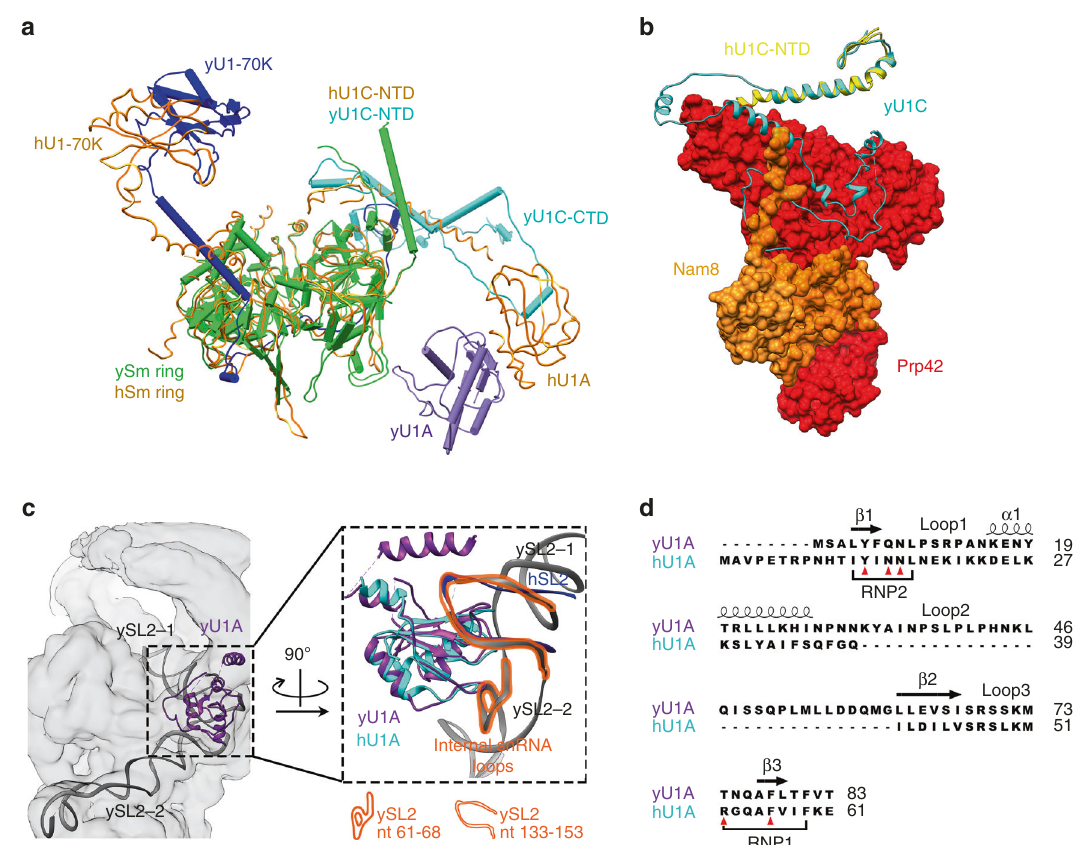
Fig. 3 The similarities and differences between yeast and human U1 snRNP core. a . The core protein components between human and yeast U1 snRNP are organized similarly. All human U1 components are colored in orange (PDB ID 3PGW and 3CW1), while yeast Sm ring, U1-70K, U1C, and U1A are colored in cyan, blue, green, and purple, respectively. The two U1 snRNPs are superimposed through their Sm rings. U1A and U1-70K positions are slightly shifted. U1C-NTDs overlap, while the U1C-CTD is not visible in the human U1 snRNP structure. b Yeast U1C-NTD (green) superimposes well with that of human U1C (yellow, PDB ID 3CW1). The C-terminal region of yeast U1C interacts extensively with Prp42 (red) and to a lesser extent with Nam8 (orange). c Yeast U1A (purple) binds to the internal loop region (nt 61 – 68 and nt 133 – 153) between SL2-1 and SL2-2 (black). In the inset panel, the human U1A RRM1 (cyan, PDB ID 1OIA) structure is superimposed on yeast U1A RRM1 (purple). The β -sheet face of yeast U1A RRM1 binds to the internal loop (nt 133 – 153, highlighted in orange) located in a similar position as the RNA (dark blue) that human U1A binds. The yeast U1A also binds to the second internal loop (nt 61 – 68, highlighted in orange) through multiple loops in its RRM1 domain. d Sequence alignment between human and yeast U1A RRM1 demonstrates differences between residues in RNP1 and RNP2 that are known to bind RNA in human U1A (red triangles) and the long loop 2 in yeast